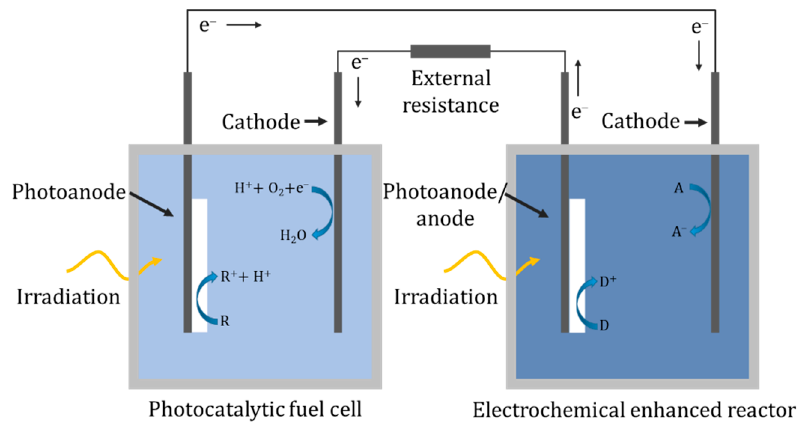
Figure 24. Hybrid system with a fuel cell used to self-bias the system and a secondary compart- ment for additional